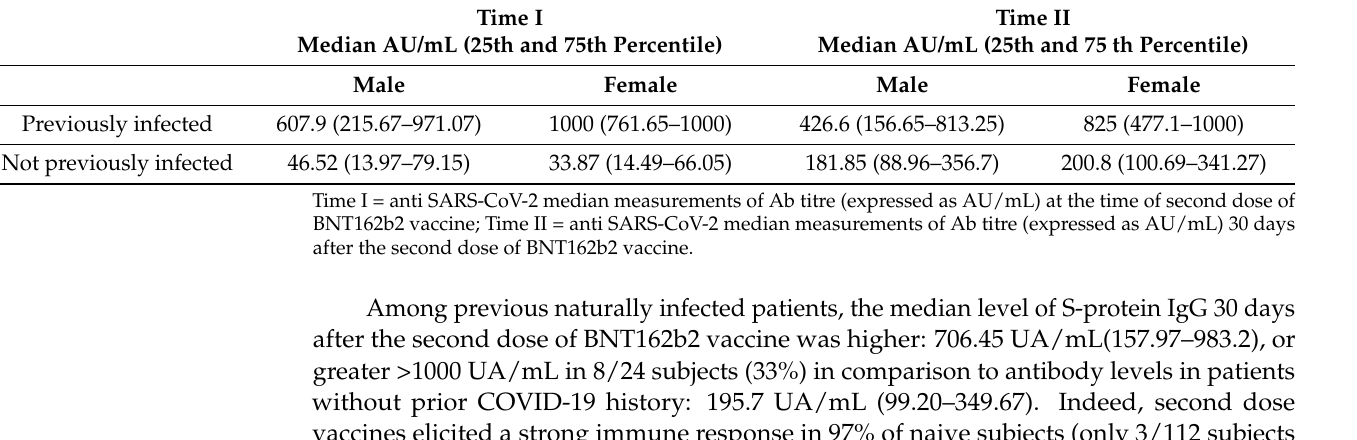
Table 2. Vaccine immune response of cohort